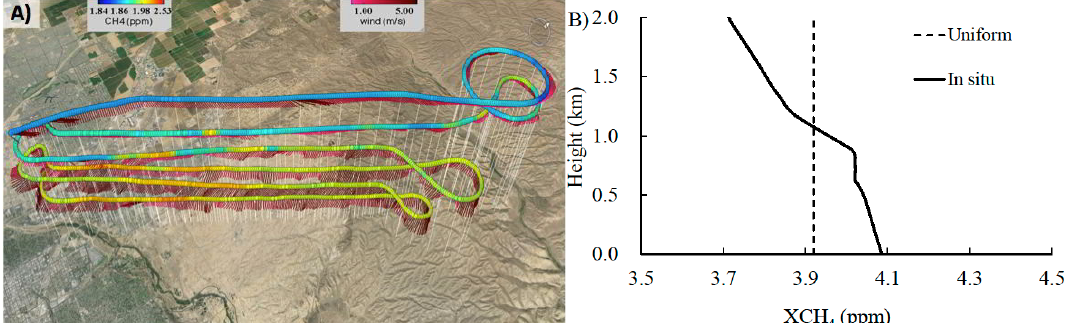
Figure 3. ( A ) In situ methane, CH 4 , and wind data for 4 September 2014 collected by CIRPAS for the Kern Front and Kern River oil fields. Data key on panel. ( B ) Derived in situ and uniform CH 4 profiles, which have the same column-averaged CH 4 within a boundary layer of 2.0 km.